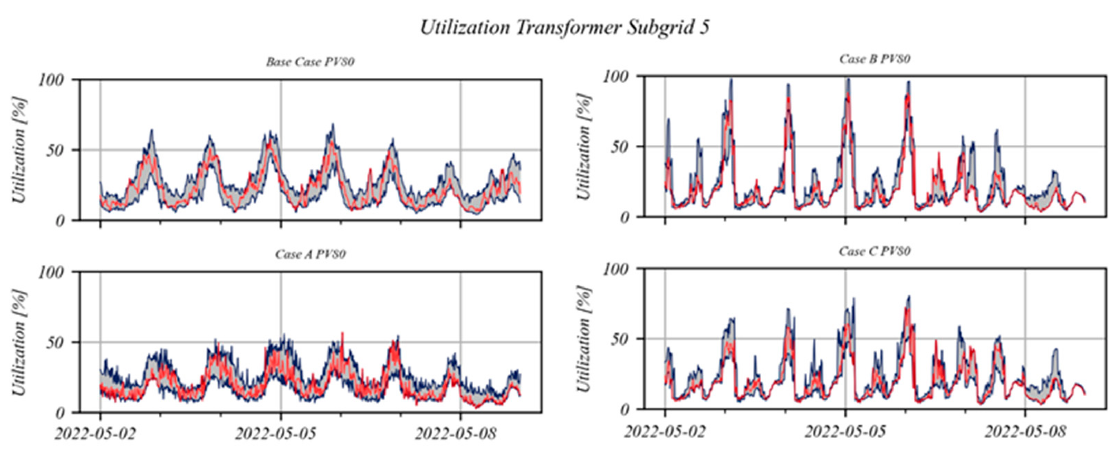
Figure 10. Utilization in percent on an exemplary subgrid throughout the different scenarios analyzed in this paper—the minimum, mean, and maximum utilization of the given transformer are shown as lower and upper band of this.